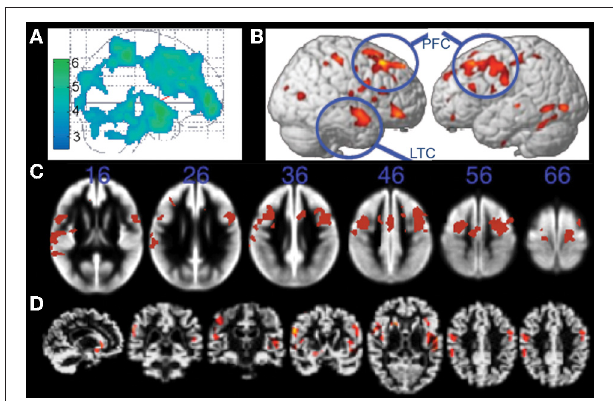
FIGURE 2 | Structural MRI studies showing positive relationships with brain volume and fitness. (A) Gray matter regions, including prefrontal cortex and parietal regions, showing fitness-related preservation in older adults. From Colcombe et al. (2003), Figure 1, p. 178. Adapted with permission. (B) Regions showing increased brain volume in older adults who walked more than 72 blocks per week. From Erickson et al. (2010), Figure 2B, p. 1419. Adapted with permission. (C) Gray matter regions, including bilateral prefrontal cortex, showing a positive relationship with fitness (after controlling for age, gender, and education) in older adults. The blue numbers represent MNI coordinates in the axial (z) plane. From Weinstein et al. (2012), Figure 1A, p. 815. Adapted with permission. (D) Brain regions showing a positive relationship with fitness (after controlling for age, education, and gender) in older adults. From Gordon et al. (2008), Figure 3A, p. 835. Adapted with permission. LTC, lateral temporal cortex; PFC, prefrontal